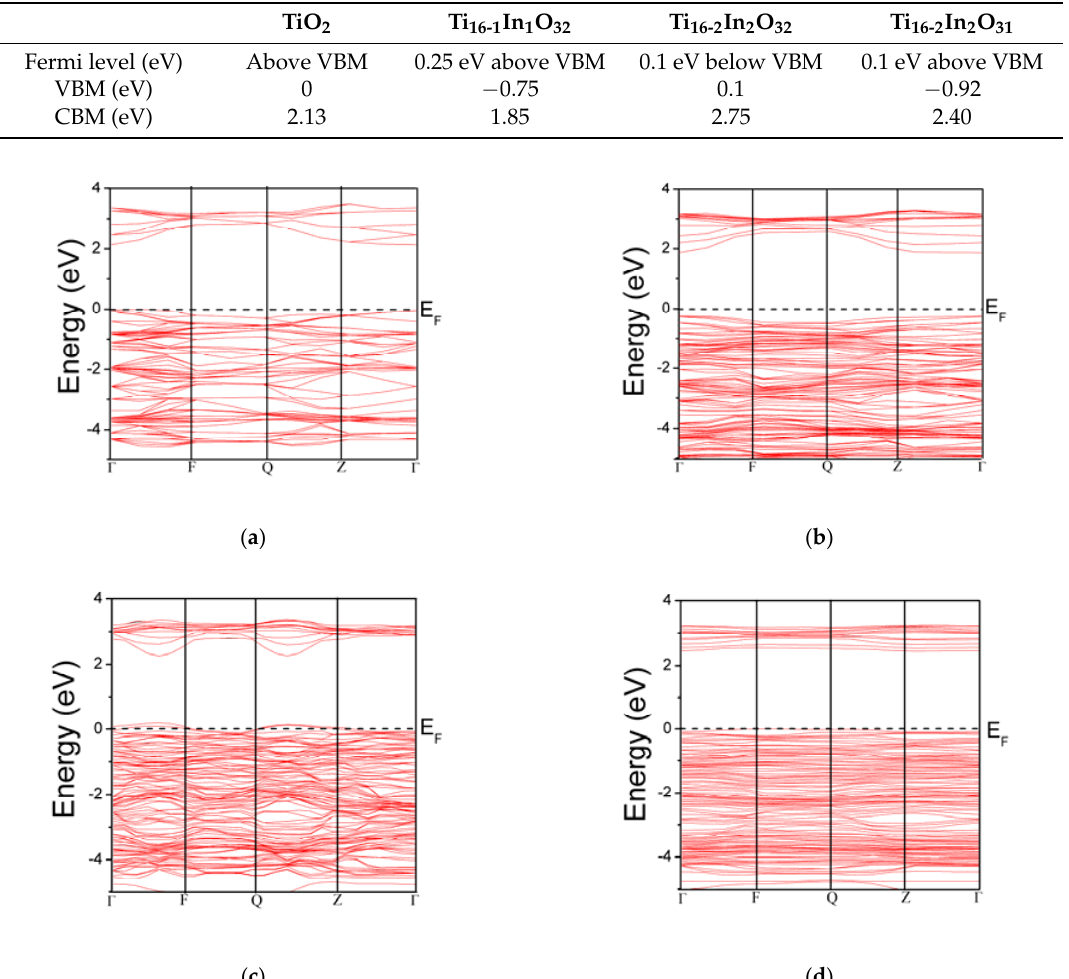
Figure 2. Band structure of TiO 2 and defect induced models: ( a ) TiO 2 ; ( b ) Ti 16-1 In 1 O 32 ; ( c ) Ti 16-2 In 2 O 32 ; and ( d ) Ti 16-2 In 2 O 31 .